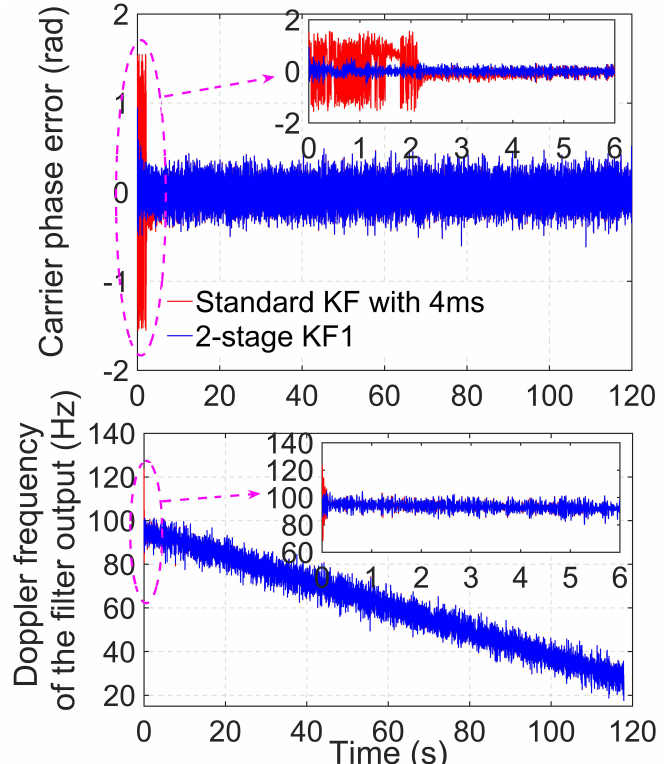
Figure 7. Carrier phase error and Doppler frequency estimations for PRN 9 satellite signals of two KF-based PLL tracking methods under a static signal of C/ N 0 = 39 dB-Hz. (KF: Kalman